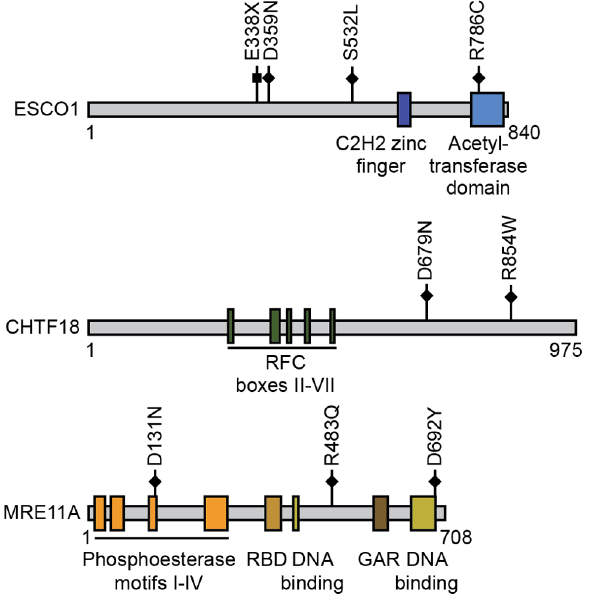
Figure 1. Localization of somatic mutations in ESCO1 , CHTF18 , and MRE11A in primary endometrial tumors, relative to important functional domains of the encoded proteins. Individual somatic mutations are indicated by squares (nonsense mutations) or diamonds (missense mutations). Domain positions are derived from [65], [66], [61], [59], [67]. GAR: Glycine-Arginine-Rich motif; RBD:RAD50 Binding Domain; RFC box: Replication Factor C box.